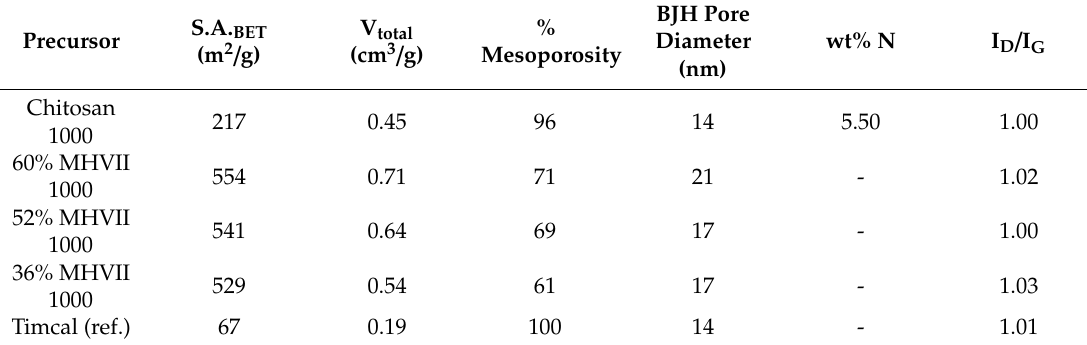
Table 7. Nanoporosity data, nitrogen content, and I D / I G of carbons obtained from starch and chitosan, carbonized at 1000 ◦ C.